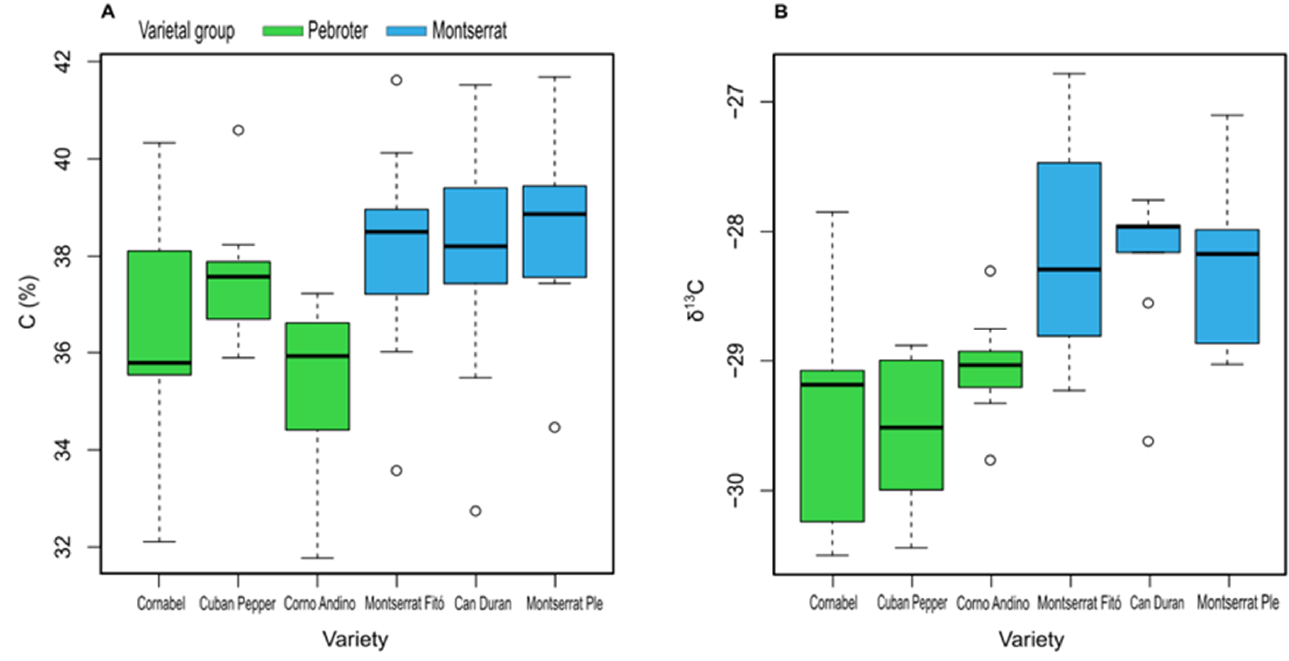
Figure 3. C ( A ) and δ 13 C ( B ) in the leaves of tomato varieties.